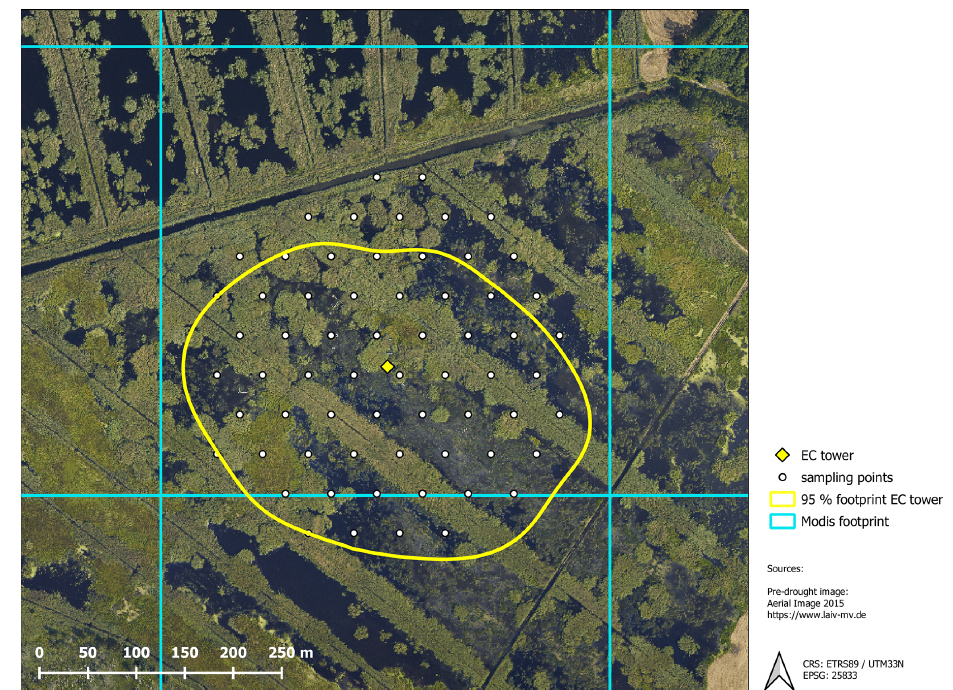
Figure B1. Spatial coverage of the different data sources including the 95% footprint climatology of the eddy covariance (EC) flux mea- surements, ground-truthing points for vegetation mapping and the grid cell used for MODIS vegetation